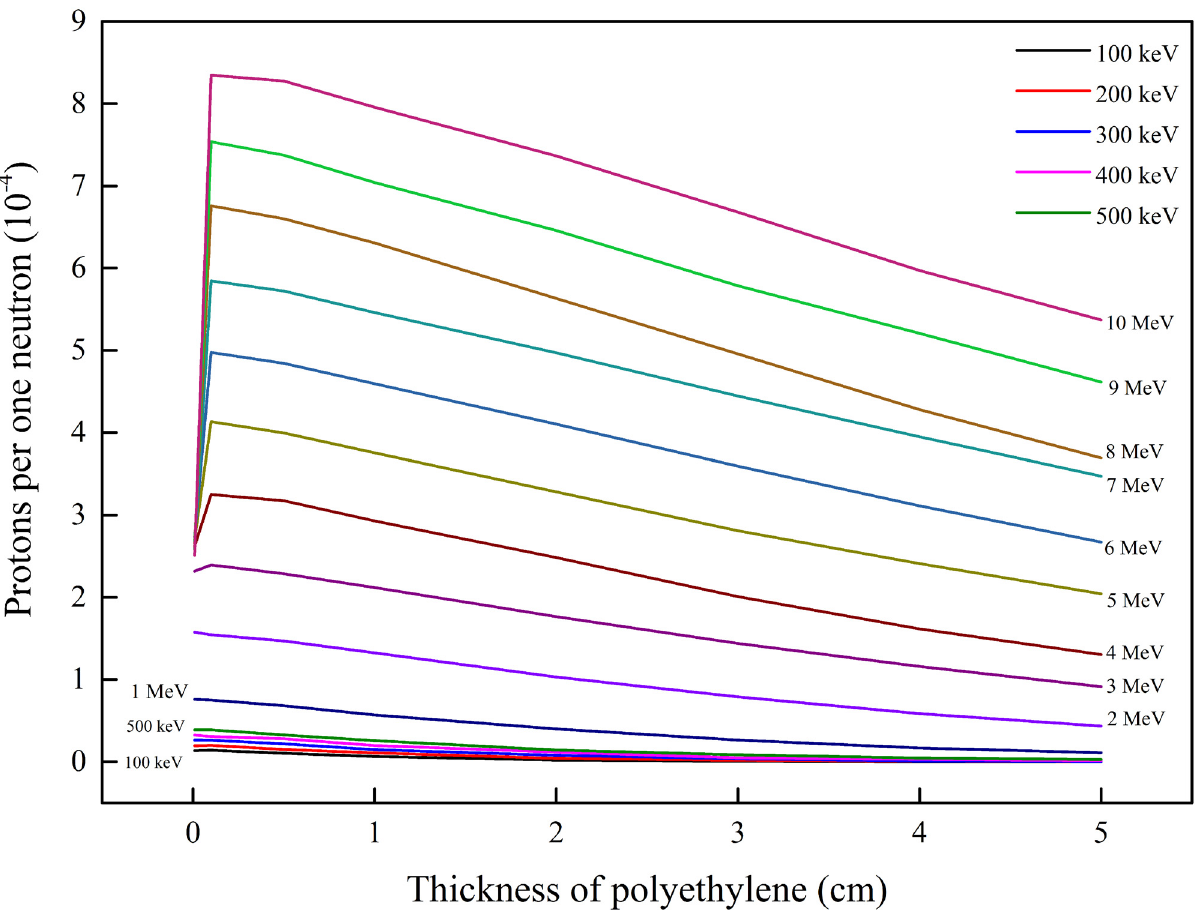
Fig 7. Efficiency of proton production as a function of the PE layer thickness with energy as a parameter (energy range from 2 to 10 MeV).